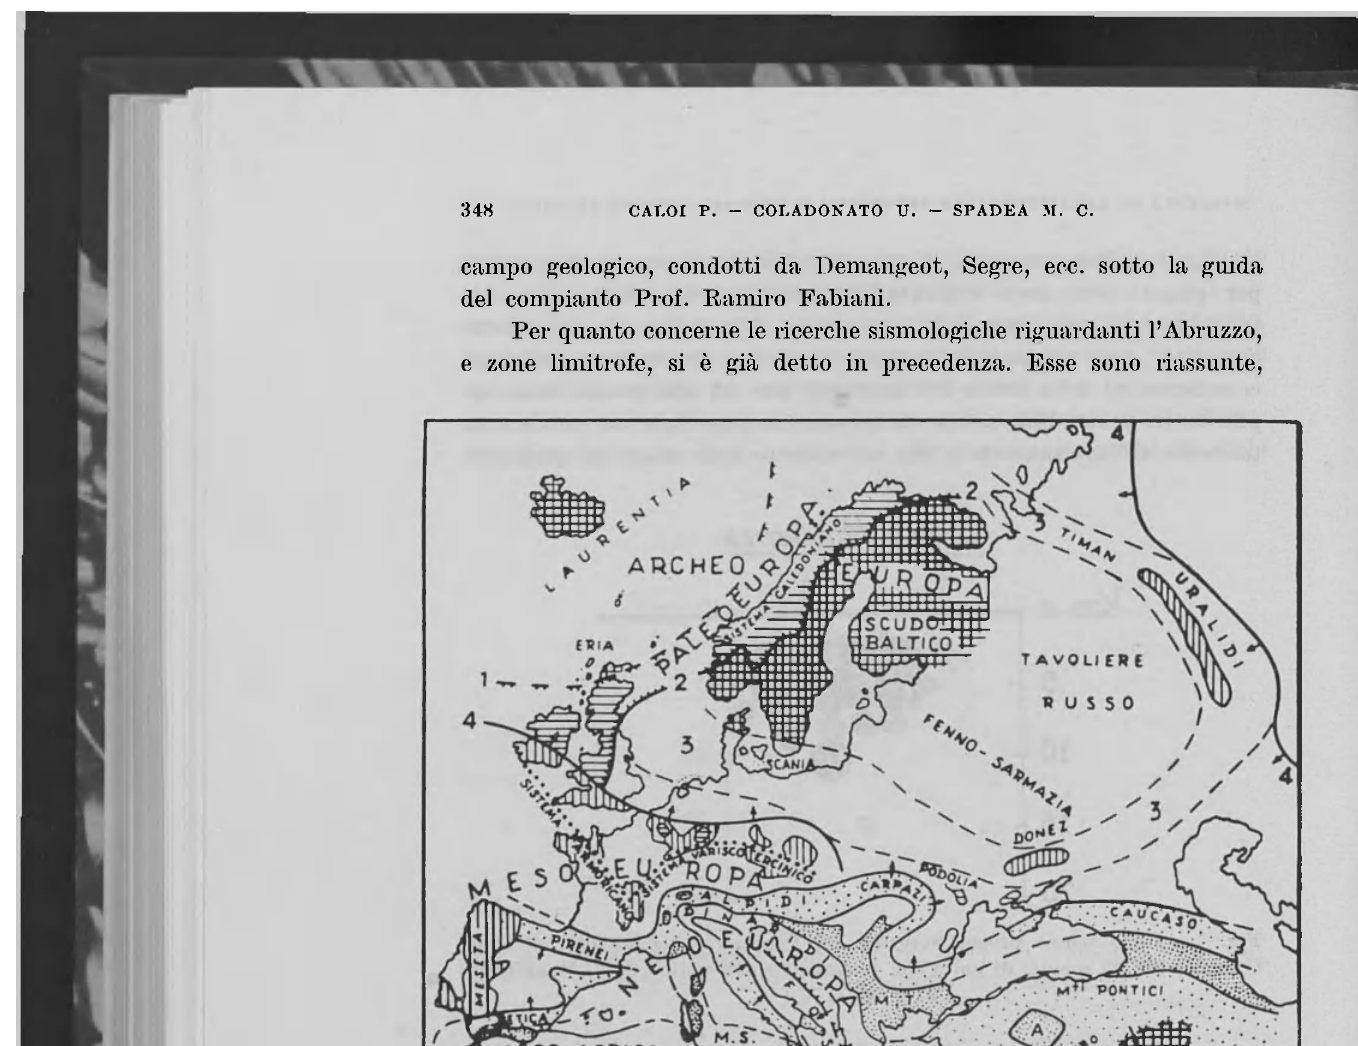
Fig. 8 - L'Italia peninsulare e la fossa adriatica, nel complesso delle zone di corrugamento in Europa (secondo Fabiani e